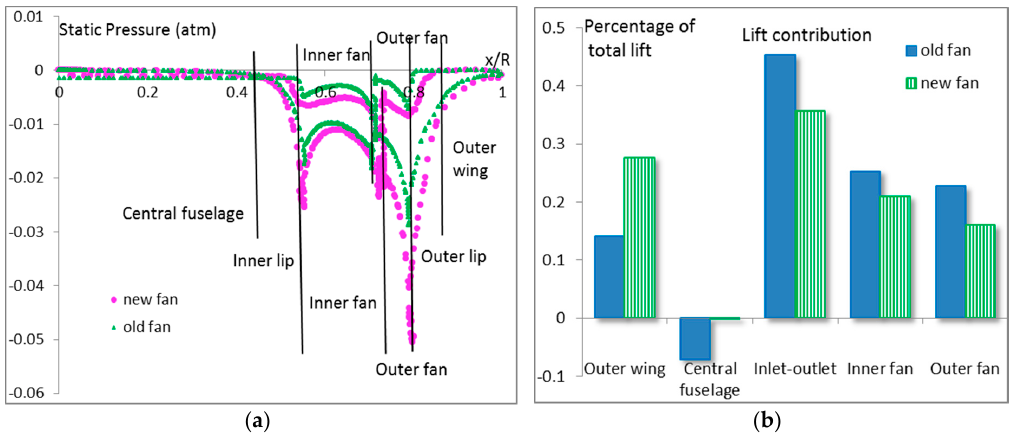
Figure 7. ( a ) Static pressure distribution on the surfaces of the aircraft in the central plane; ( b ) Lift distribution.